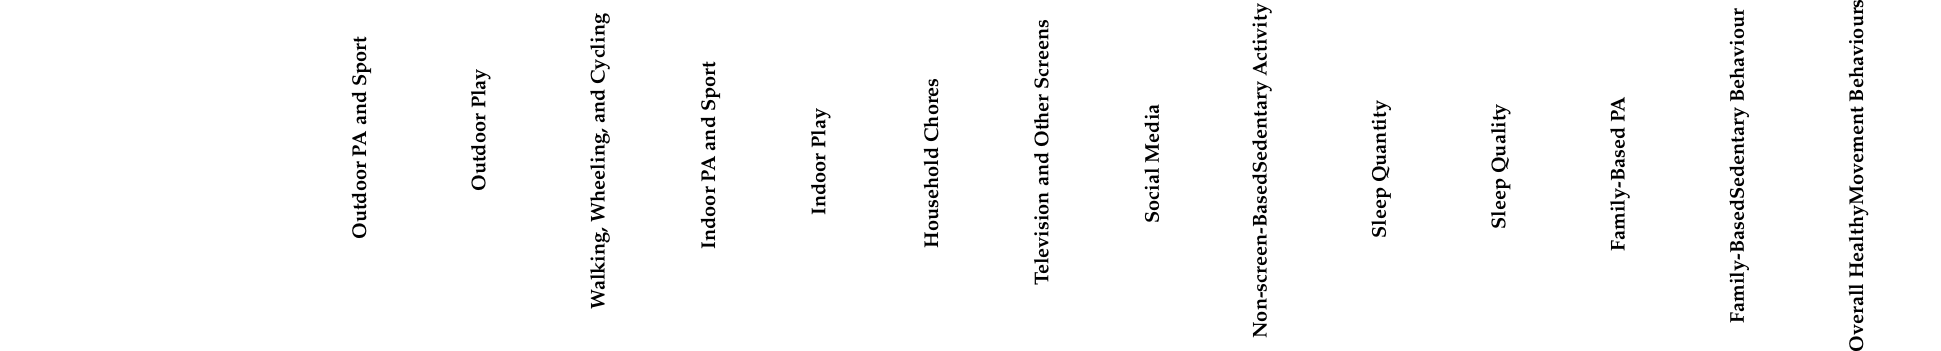
Table 6. Associations between parental support and parent-perceived changes in their child’s movement behaviours during the COVID-19 pandemic (May 2020; N =